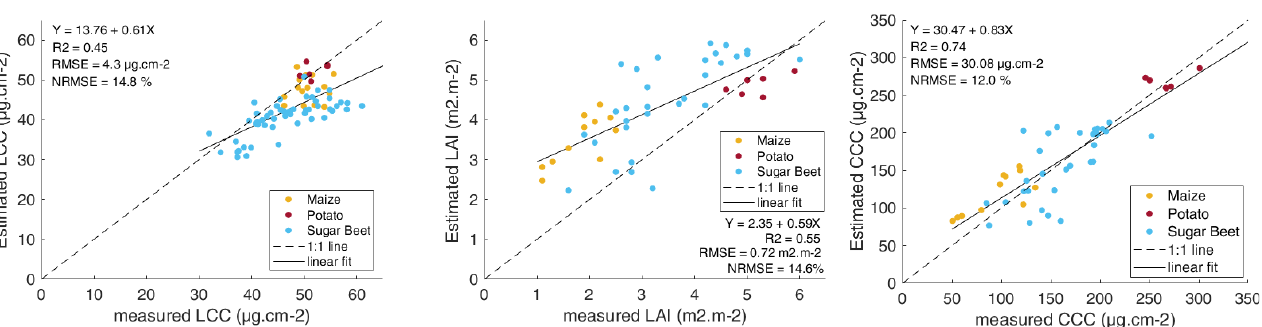
Figure 4. Validation of the fine-scale variable estimations at 3 m spatial resolution. Estimated values were generated by applying the retrieval models to a subset of a 3 m resolution HyPlant DUAL image. In situ measurements were gathered over crop fields (sugar beet, maize, and potato) near Jülich (Germany) and compared to the average of the pixel estimations falling within a 9 m diameter buffer, centered at each field